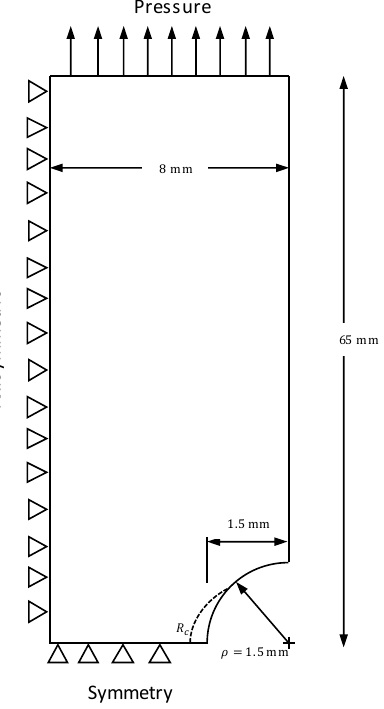
Figure 6. Schematic of the finite element model.